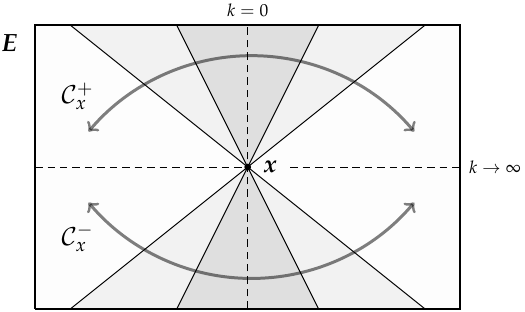
Figure 4. Sheaves of future and past causal cones. x sits at the common tip of the cones. The cones widen as k increases. For k = 0 the cones shrink to segments, and for k → ∞ the cones coincide to the whole past ( E − x ) and future( E + x ) of x